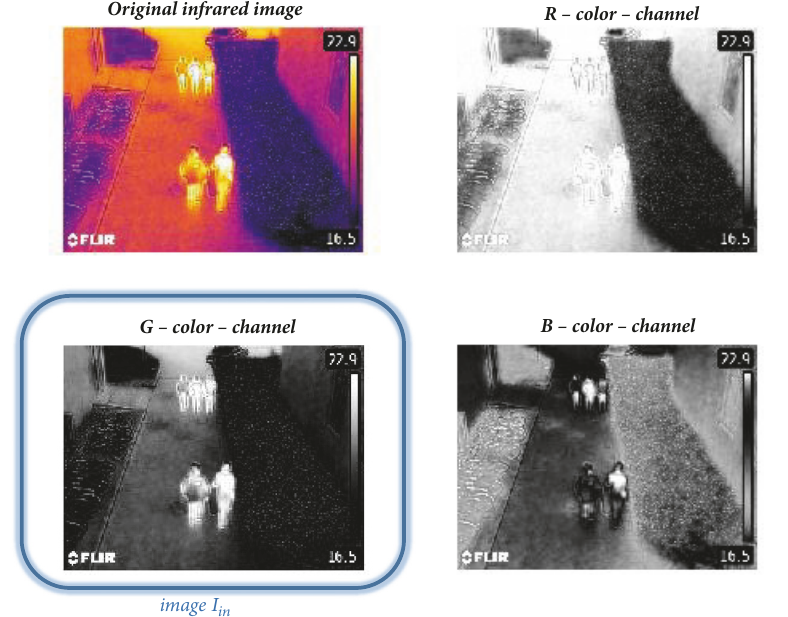
Figure 3: The RGB analysis of infrared images.